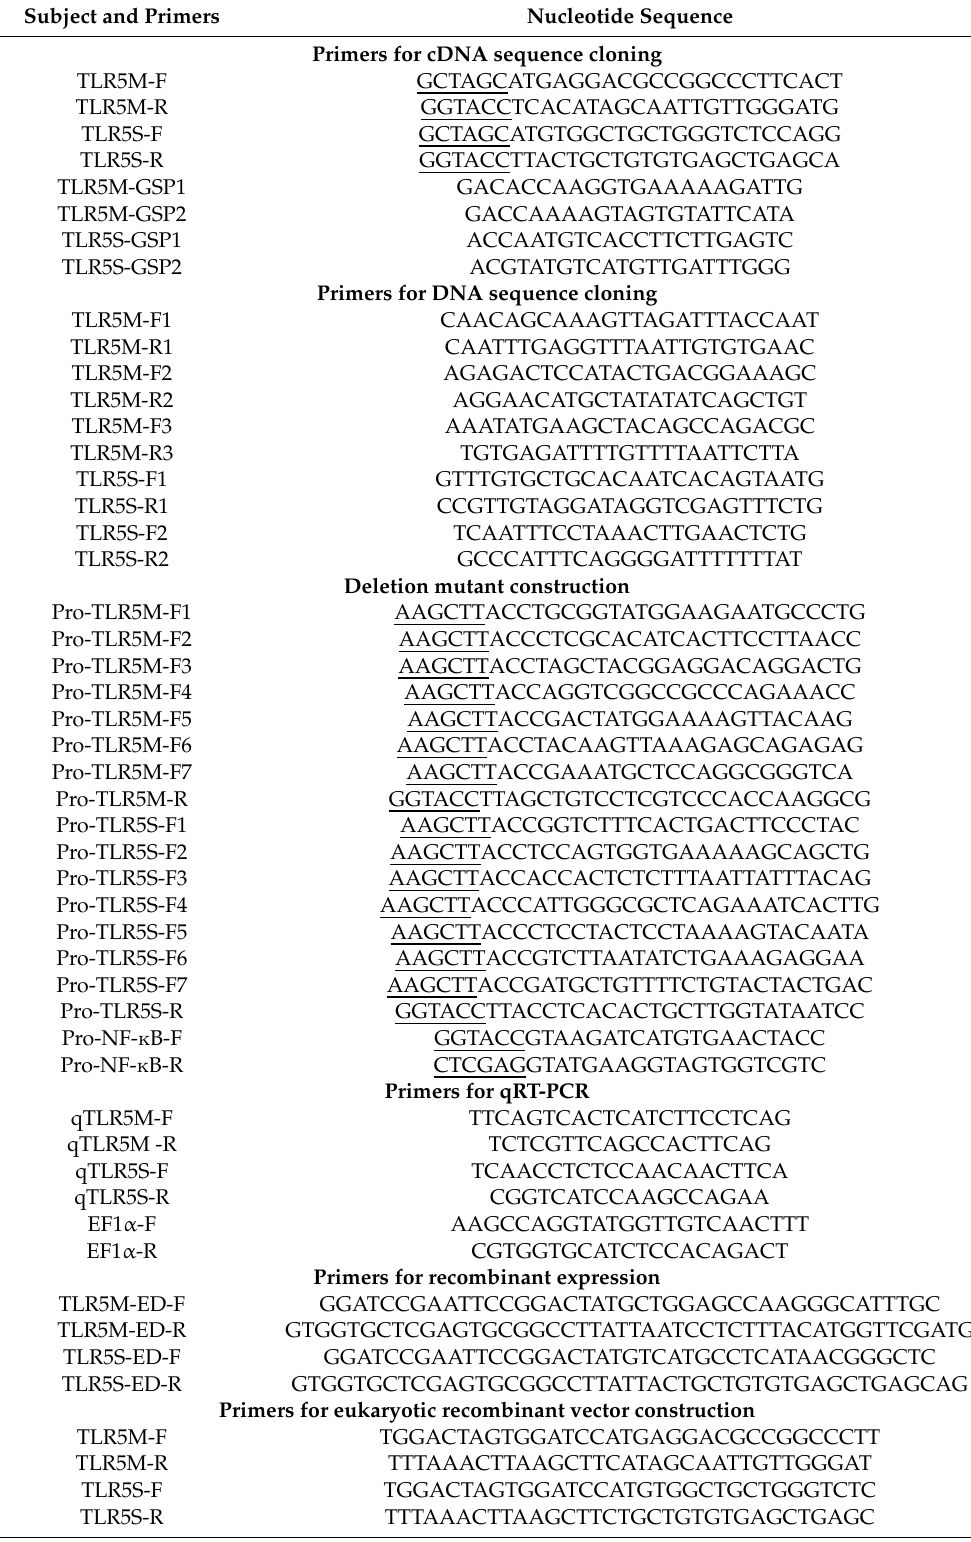
Table 1. Primers used for sequence cloning, deletion mutant construction, mRNA construction, and